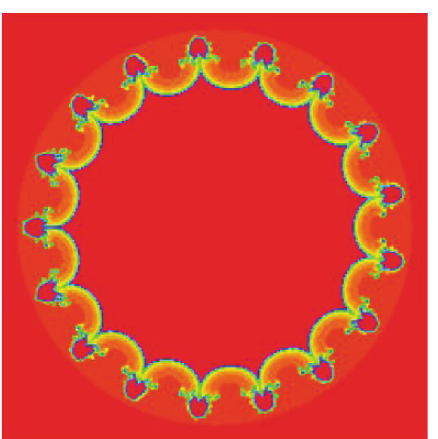
Figure 24: Relative superior multicorn for 𝑠 = 0.4 , 𝑠 󸀠 = 0.6 , and 𝑛 = 16